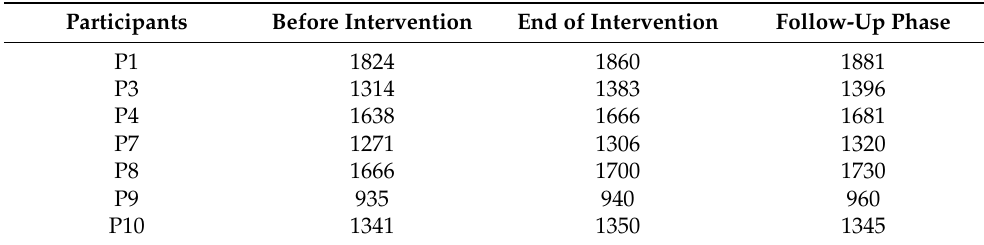
Table 8. Performance in terms of points accumulated in competition before, at the end, and after the intervention for the participants. Participants Before Intervention End of Intervention Follow-Up Phase 1824